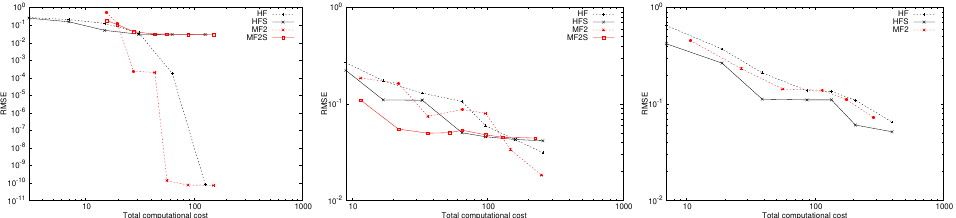
Figure 15. PCE: ALOS function RMSE (from left to right, one, two and three dimensions). PCE and SPCE in dashed and solid lines, respectively.